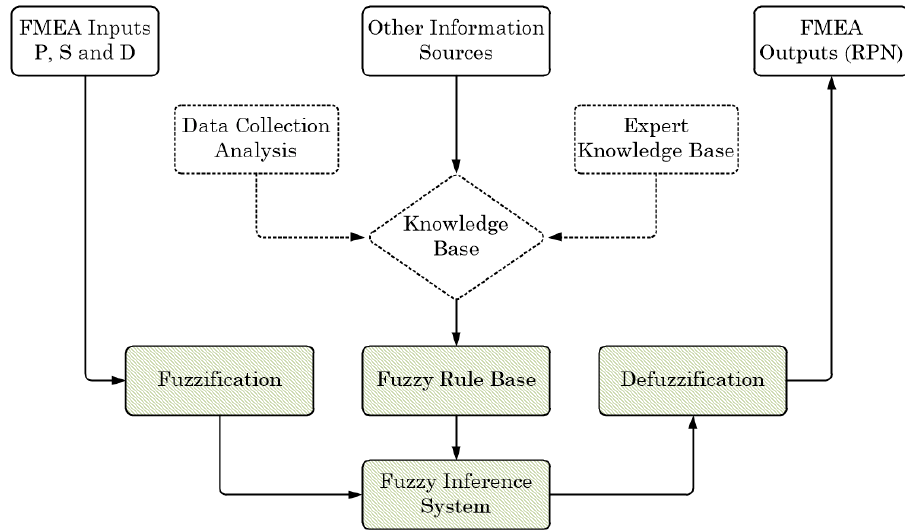
Figure 1. Fuzzy inference system (adapted from [10]).